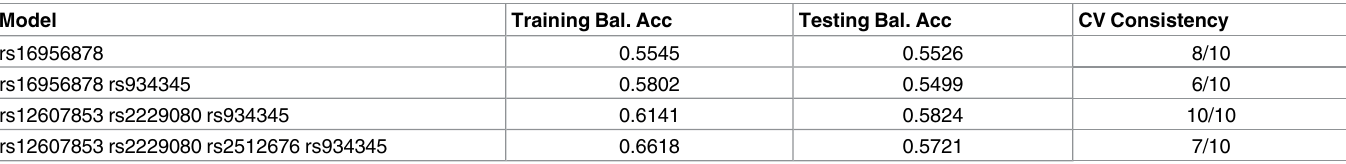
Table 4. The results of gene-gene interactions using MDR.